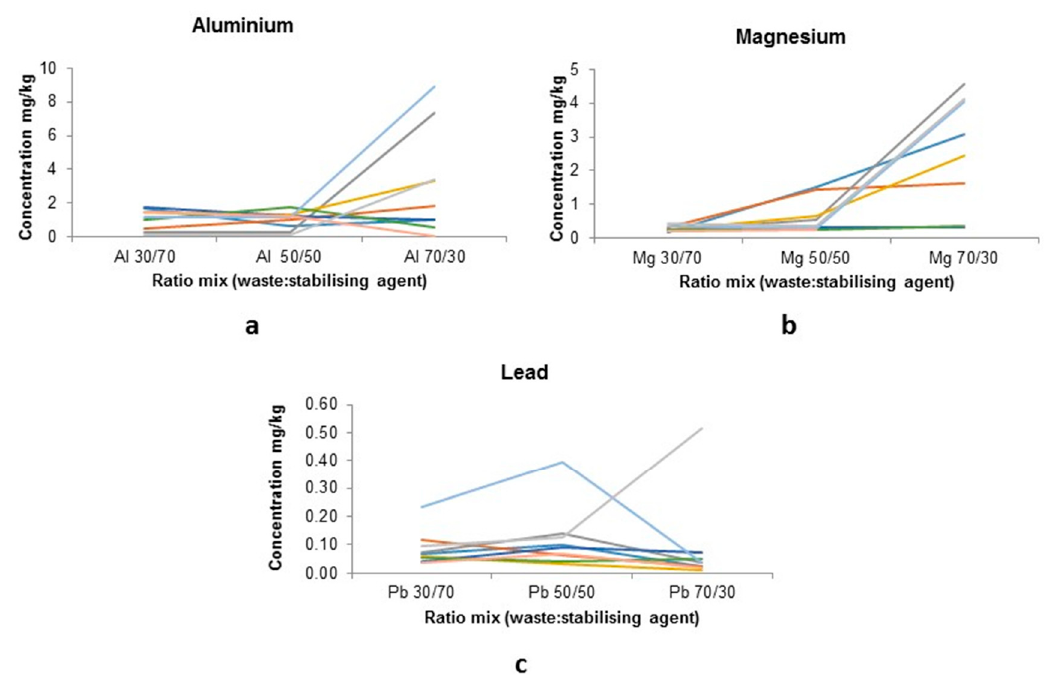
Figure 5. Total PTE content in leachate of sinter ESP dust and BF slag mix: ( a ) Al; ( b ) Mg; and ( c ) Pb—different colours represent nine different samples from the sinter plant.